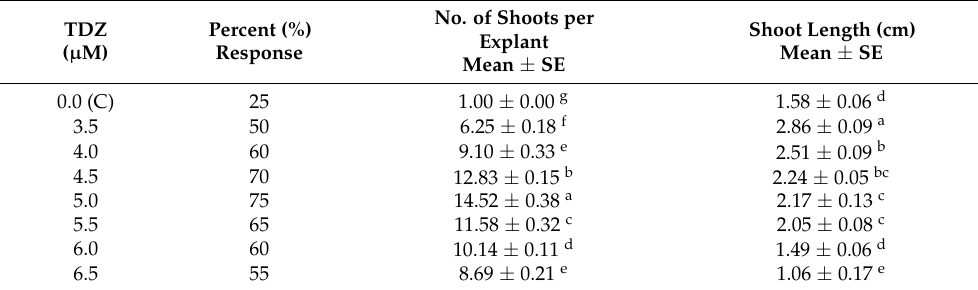
Table 2. Secondary (or narrow) screening of TDZ for multiple shoot induction from node explants of L. speciosa after 4 weeks of